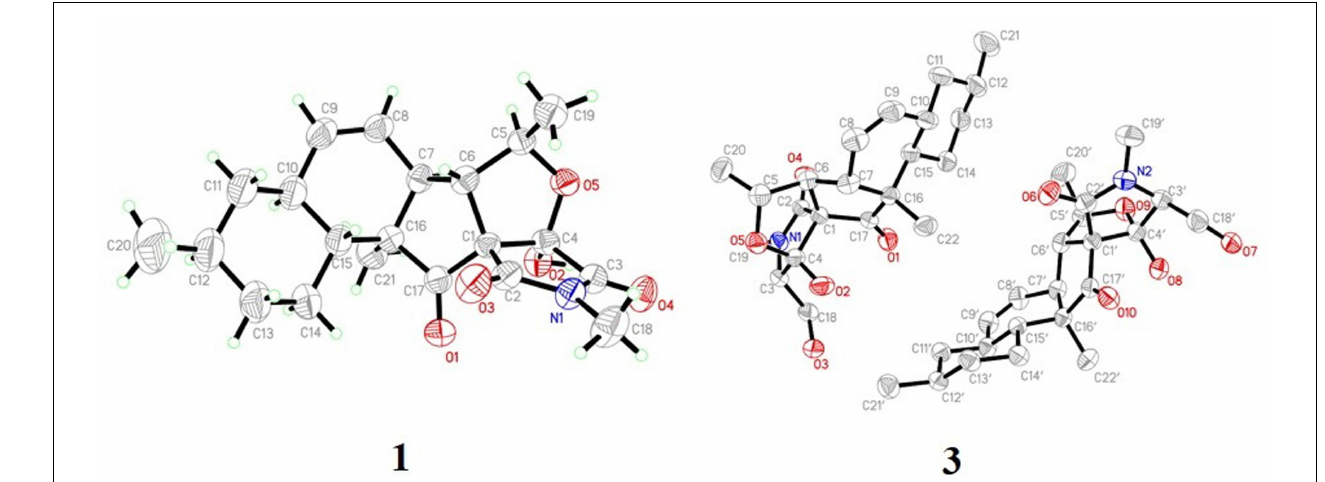
FIGURE 4 | X-ray structure of 1 and 3